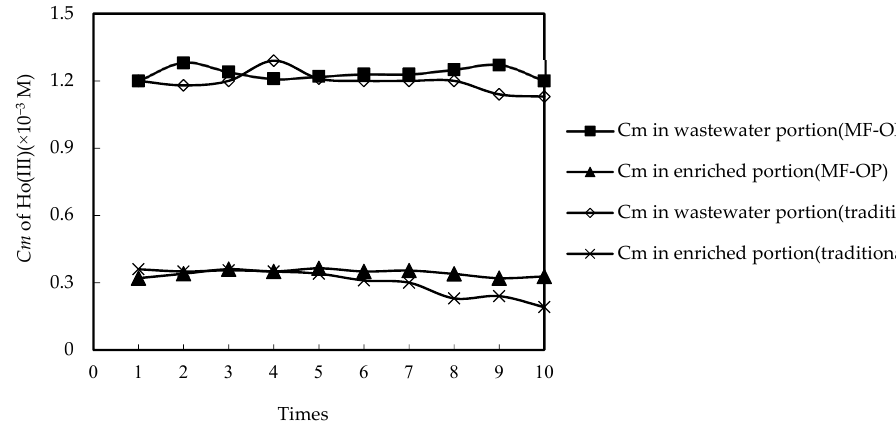
Figure 3. The constancy comparison of MF-OP and traditional SFF.